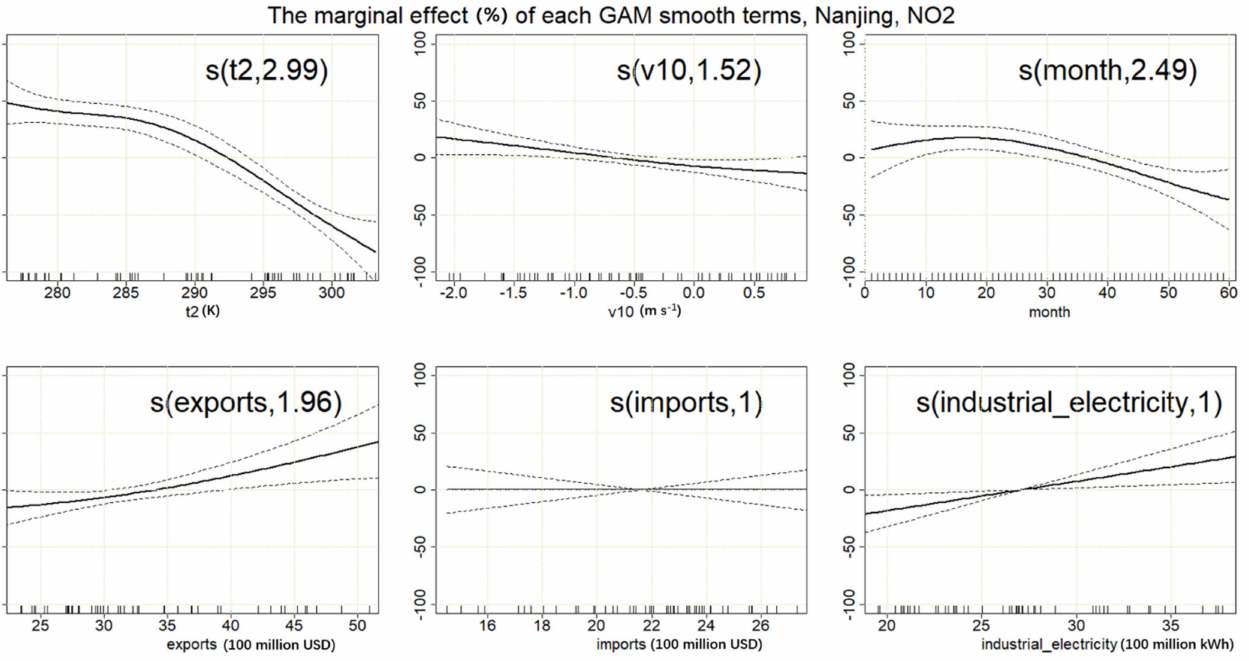
Figure 5. The marginal effect (%) of each GAM smooth term on tropospheric NO 2 VCDs of Nanjing. The response curves of t2, v10, month, exports, imports, and industrial electricity are shown in separate